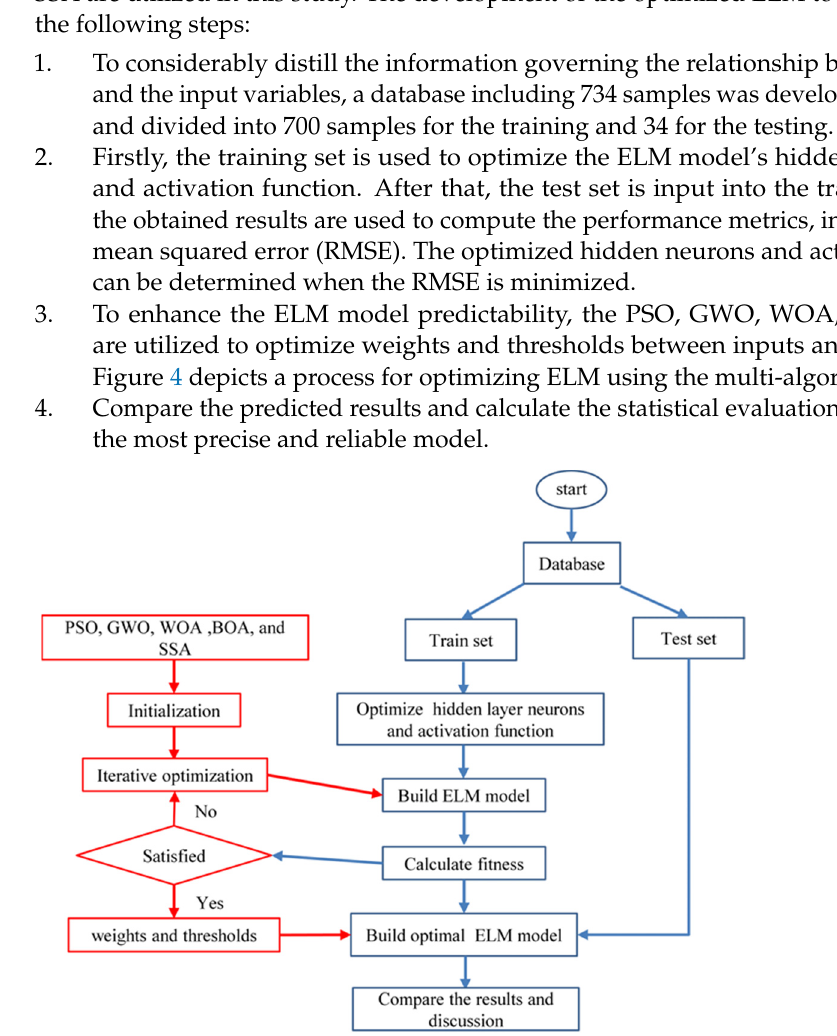
Figure 4. The process for optimizing the ELM using the PSO, GWO, WOA, BOA, and SSA.